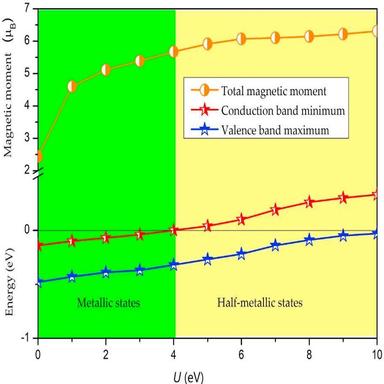
The effect of different on-site Coulomb interaction U (U ¼ 1–10 eV) values on the electronic structures and magnetic moment.